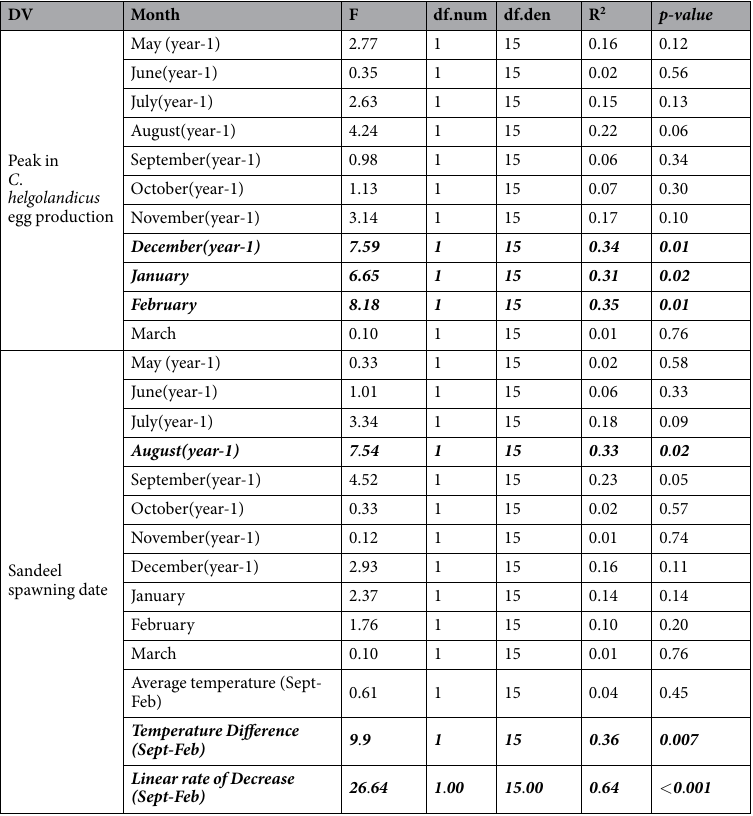
Table 1. Linear regressions between monthly average sea temperatures and key phenological events in Calanus helgolandicus and